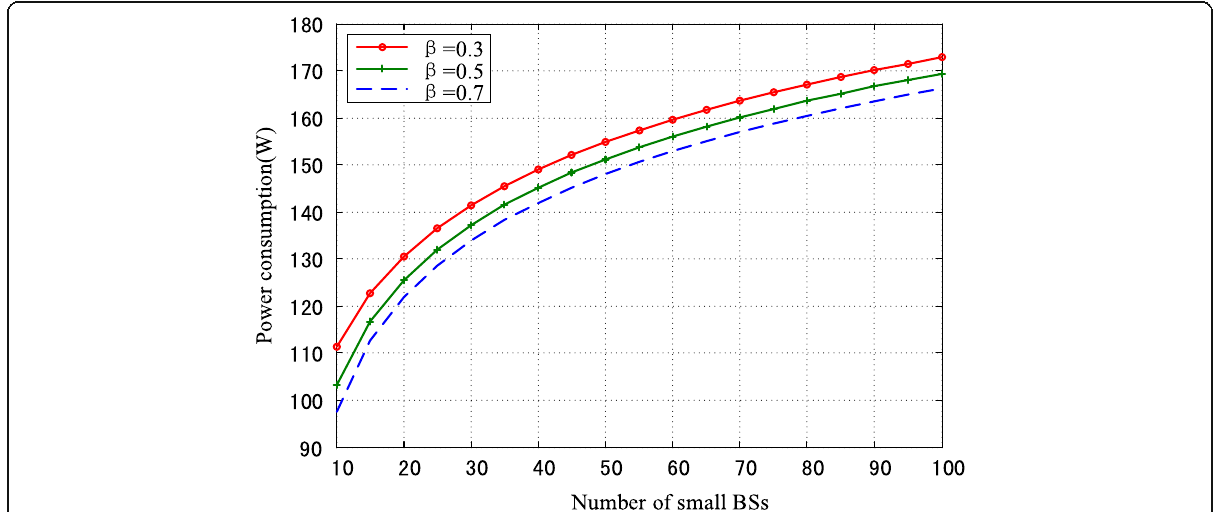
Fig. 5 Comparison of power consumption with varying factor of β . In Fig. 5, we compare the power consumption of the system in terms of β . It is observed that the power consumption of the system decreases because a larger β implies a higher weight of the factor of power consumption. Therefore, we can set these two parameters to get a tradeoff between α and β according to the requirement of the